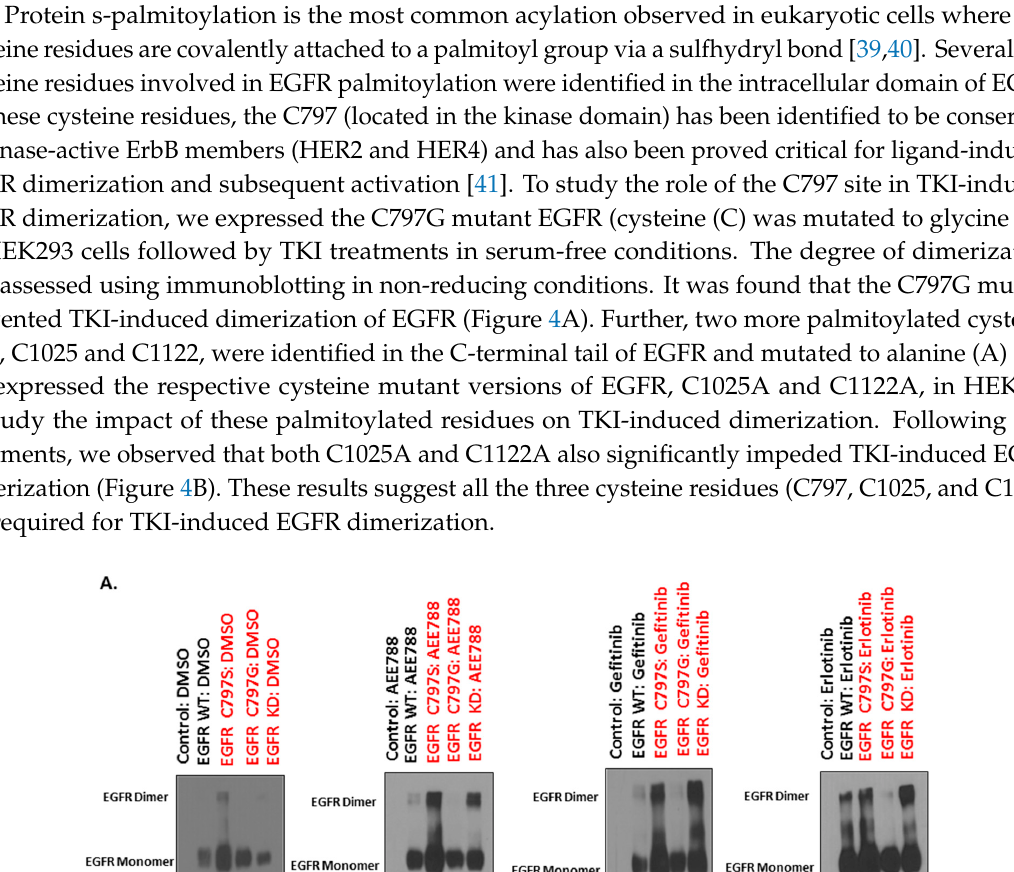
cysteine residues are covalently attached to a palmitoyl group via a sulfhydryl bond [39,40]. Several key cysteine residues involved in EGFR palmitoylation were identified in the intracellular domain of EGFR. Of these cysteine residues, the C797 (located in the kinase domain) has been identified to be conserved in kinase-active ErbB members (HER2 and HER4) and has also been proved critical for ligand-induced EGFR dimerization and subsequent activation [41]. To study the role of the C797 site in TKI-induced EGFR dimerization, we expressed the C797G mutant EGFR (cysteine (C )was mutated to glycine (G)) in HEK293 cells followed by TKI treatments in serum-free conditions. The degree of dimerization was assessed using immunoblotting in non-reducing conditions. It was found that the C797G mutant prevented TKI-induced dimerization of EGFR (Figure 4A). Further, two more palmitoylated cysteine sites, C1025 and C1122, were identified in the C-terminal tail of EGFR and